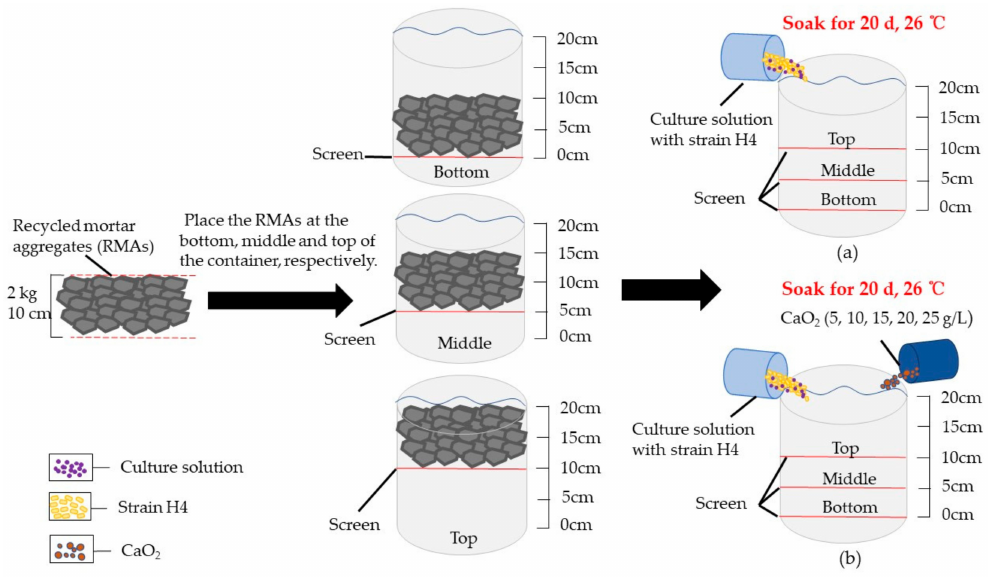
Figure 1. Treatment of recycled mortar aggregates (RMAs): ( a ) RMAs were immersed in the container containing bacteria solution and placed at di ff erent positions, respectively. ( b ) RMAs were immersed in the container containing bacteria solution and placed at di ff erent positions, di ff erent concentration of CaO 2 added,